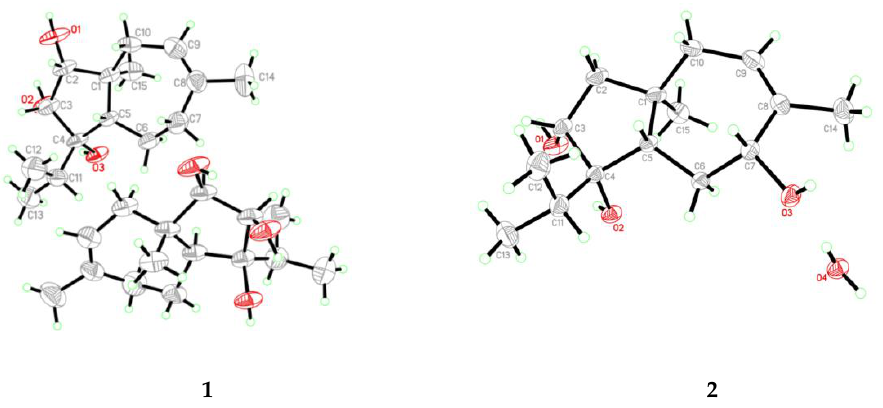
Figure 4. X-ray crystallographic structures of compounds 1 and 2 .